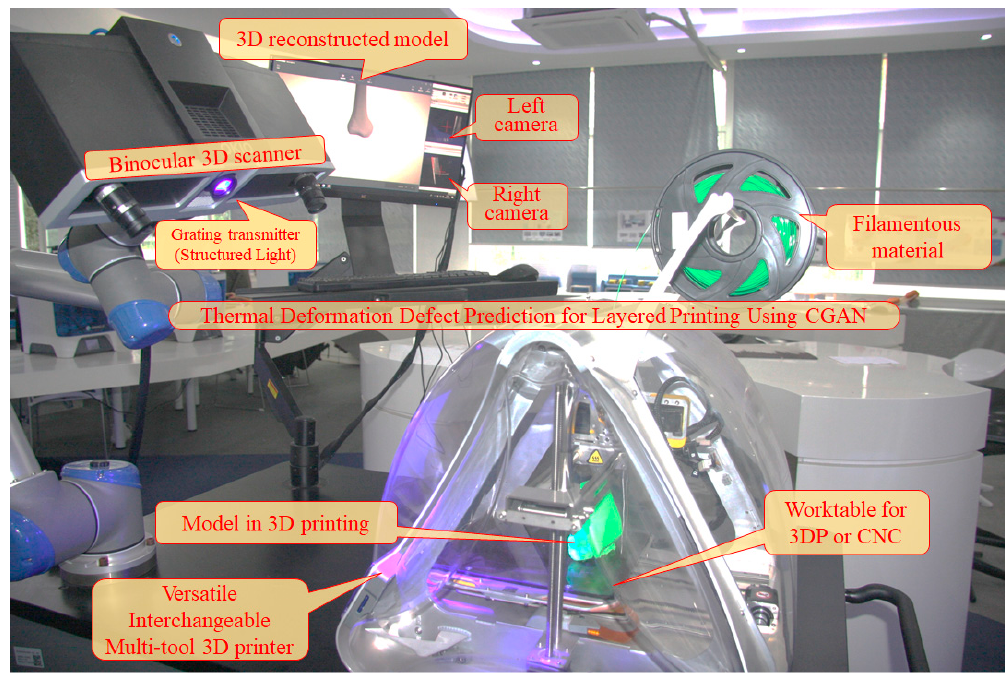
Figure 9. Binocular stereo vision laser scanner for 3D reconstruction of printed objects.